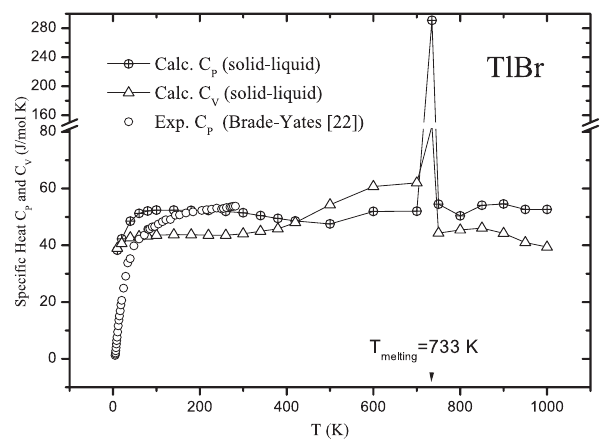
Fig. 4: Variation of specific heat constant pressure and constant volume with temperature for TlBr.